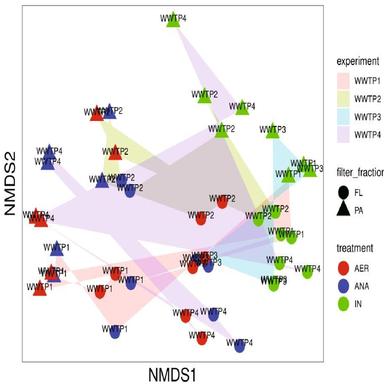
NMDS plot based on Bray–Curtis distance matrices of bacterial communities. Circles represent the free-living communities (FL) and triangles the particleattached communities (PA). IN: influent; AE: aerobic; AN: anaerobic.